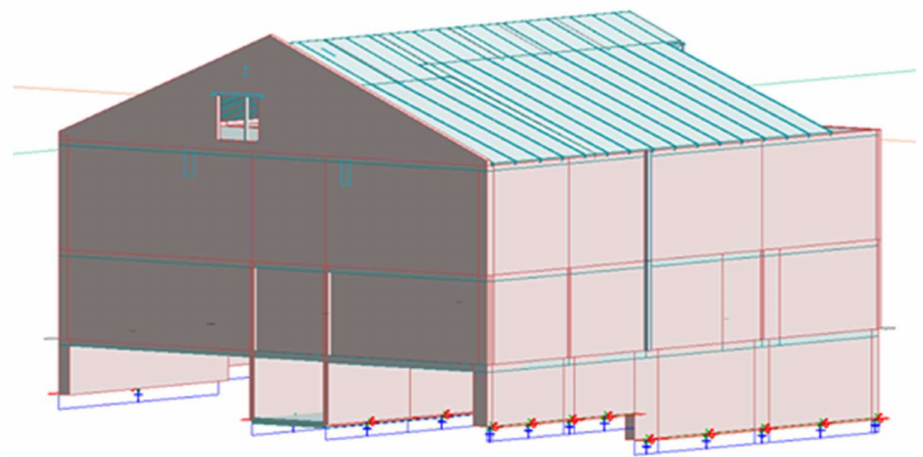
Figure 14. 3D view of the modeled building.